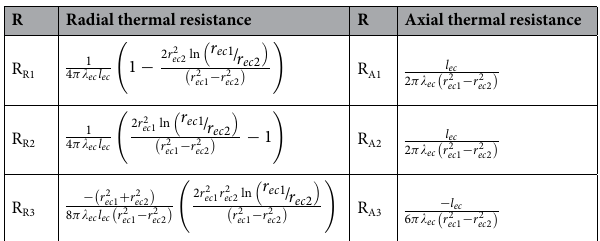
Table 1. Thermal resistances for T-equivalent thermal circuit of the excitation coil 18 .